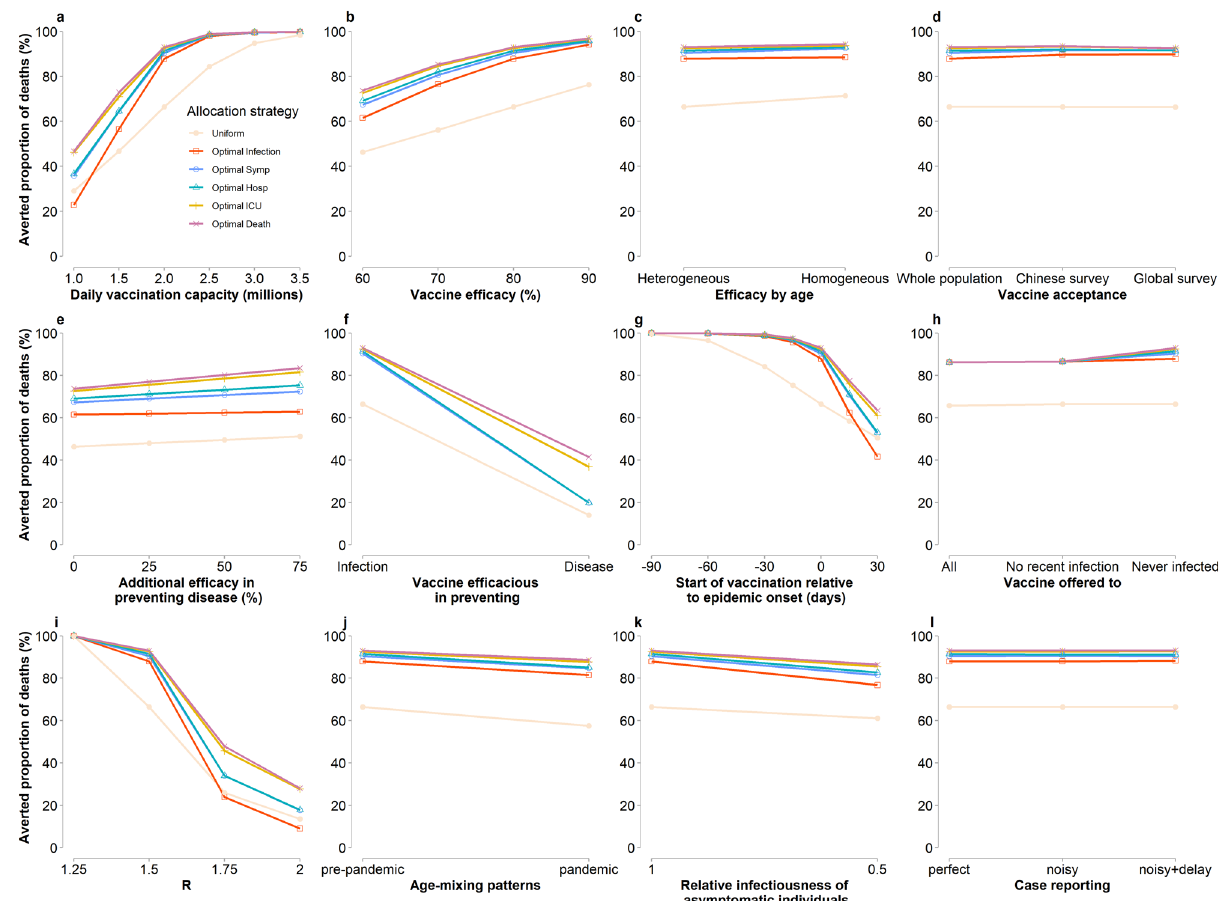
Fig. 3 Effectiveness of alternative vaccination strategies under alternative assumptions. a Averted proportion of deaths for different strategies (uniform vaccination and the fi ve optimal strategies) as compared to no vaccination for different values of the vaccination capacity. b As ( a ), but for different